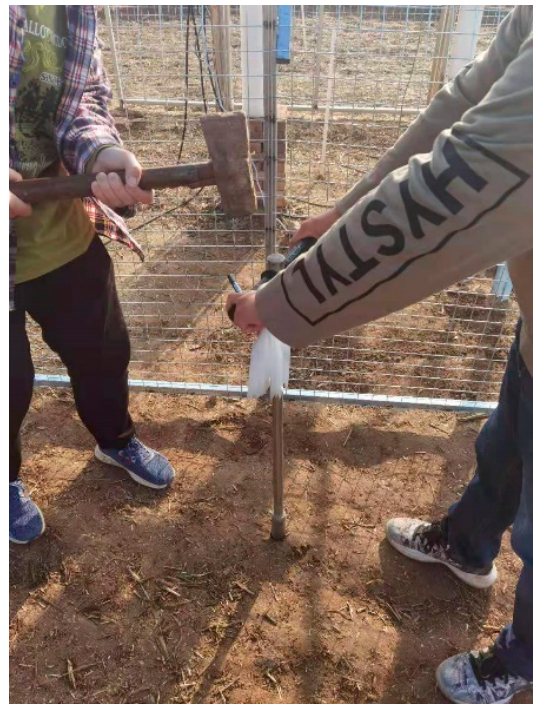
Figure 6. Manual measurement of soil moisture.